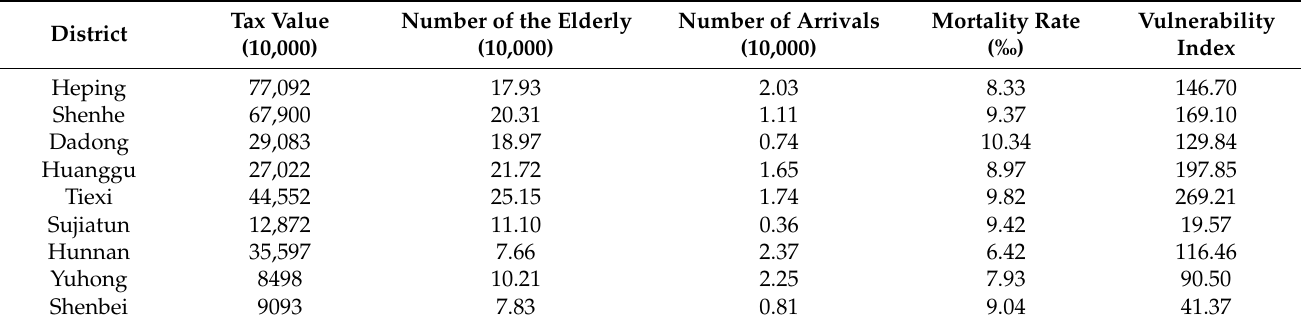
Table 1. List of vulnerability factors and vulnerability index in each